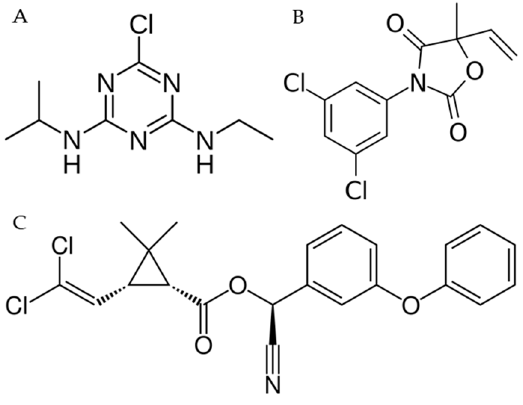
Figure 1. Chemical structures of ATZ ( A ), VNZ ( B ) and CYP ( C